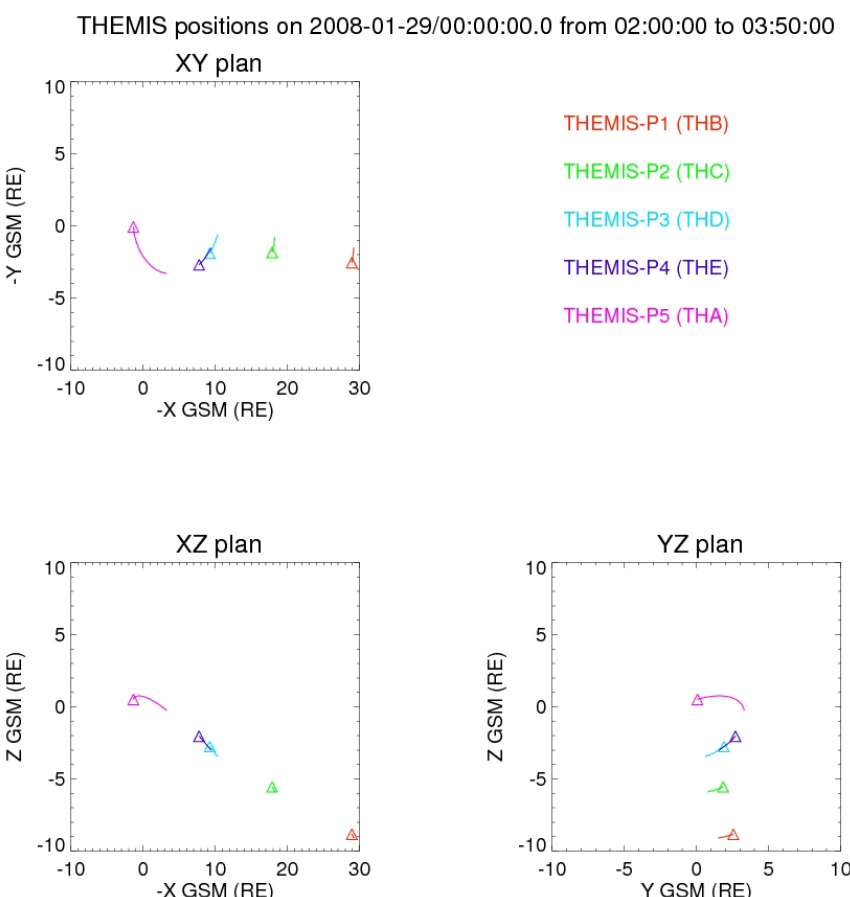
Fig. 1. The locations of the THEMIS probes on the different GSM planes on 29 January 2008. The starting time at 02:00UT and their trajectories between 02:00 and 03:50UT are indicated by a triangle and a curve, respectively.